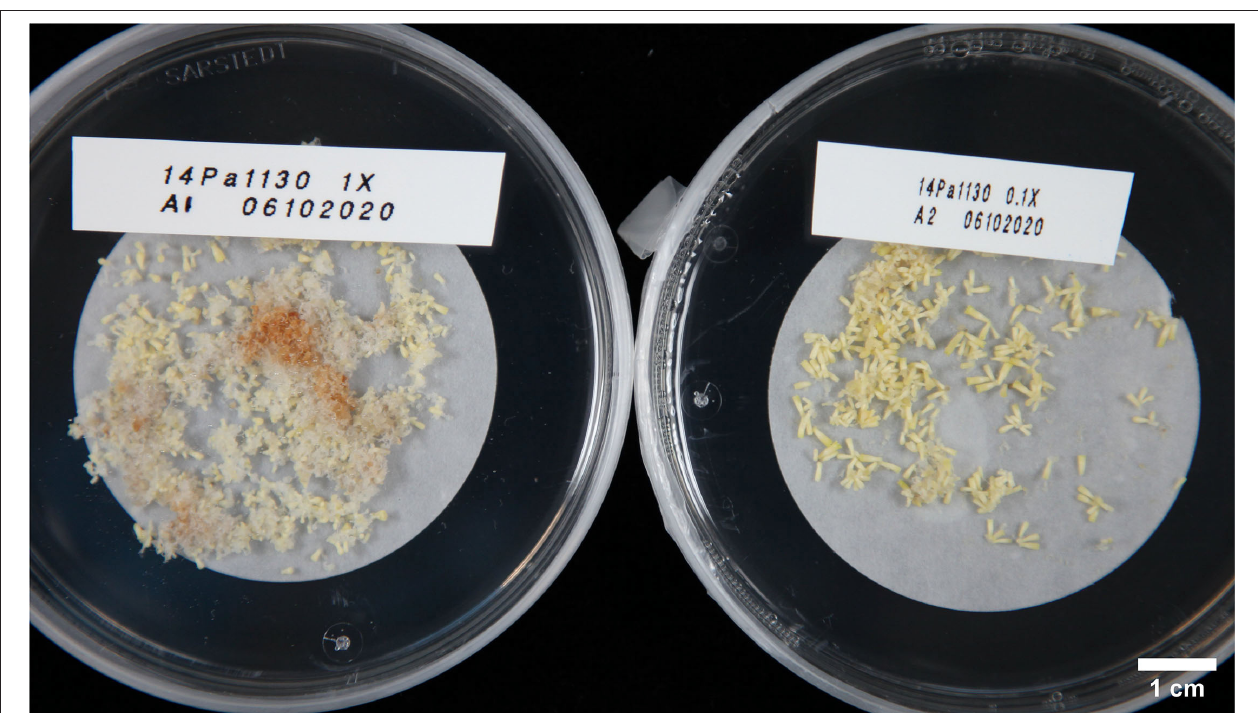
FIGURE 4 | Embryos from line 1,130 photographed 23 days after transfer from proliferation to maturation with rinsing in Experiment IV. The left plate has been matured from 1x PGR suspension and the right plate from 0.1x PGR